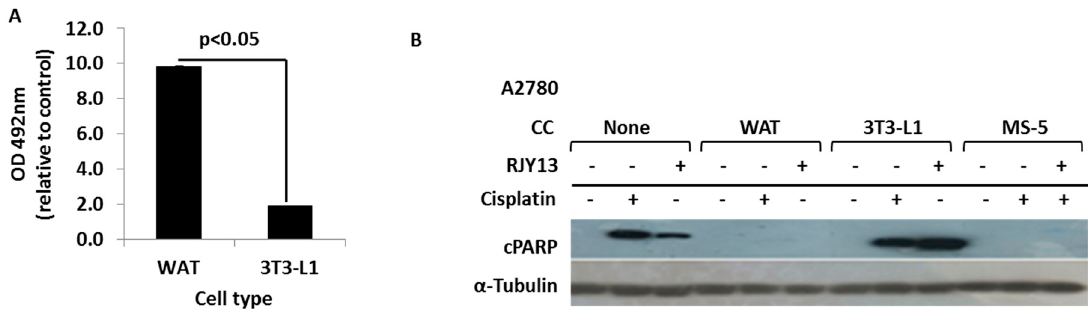
Figure 3. Di ff erentiated 3T3-L1 cells confer drug resistance to OC cells. Murine adipocyte progenitor 3T3-L1 cells were stimulated to di ff erentiate to white adipocytes (WAT) and the presence of fat droplets was determined using Oil red staining ( A ). A2780 cells exposed to platinum compounds (5 µ M RJY13 or 25 µ M cisplatin) were co-cultured with di ff erentiated (WAT) and undi ff erentiated 3T3-L1 cells as well as MS-5 cells ( B ). Levels of cleaved PARP (cPARP) were monitored in the di ff erent samples by immunoblotting using human selective anti-cPARP antibody ( B ). α -Tubulin was used as a loading control. The experiment was repeated twice with comparable outcomes. CC, co-culture .